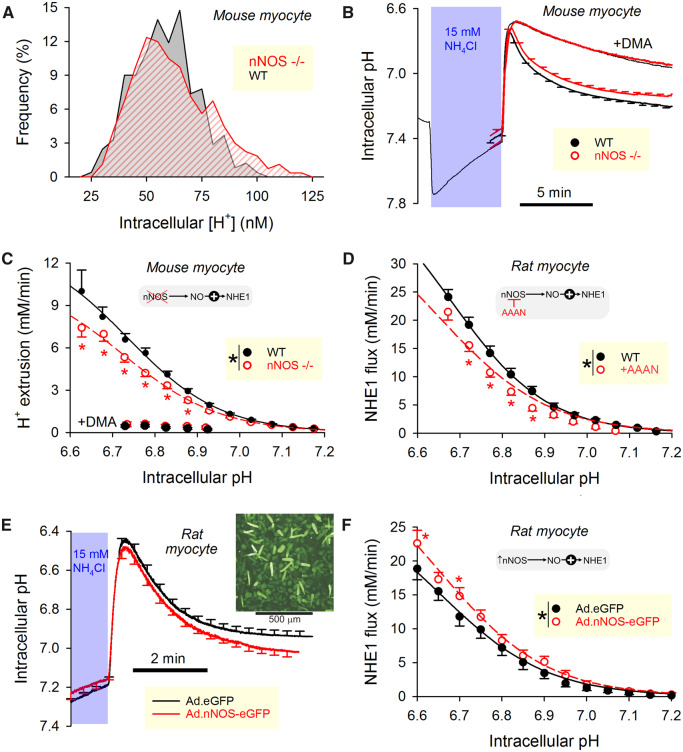
nNOS-derived NO activates NHE1 activity. (A) Histogram of resting [H+]i in ventricular myocytes isolated from nNOS knockout mice (N = 267 from five mice) or their wild-type littermates (N = 244 from five mice). (B) Time course of ammonium prepulse (mean ± SEM; N = 64 from five nNOS knockout mice and N = 54 from five wild-type littermates). Hepes-buffered superfusates, 37°C. Solution manoeuvre acid-loaded myocytes to interrogate acid-extrusion fluxes during recovery phase (blocked by 30 µM dimethylamiloride, DMA). (C) Flux calculated from the rate of pHi change and buffering capacity (Supplementary material online, Figure S2). NHE1-dependent fluxes were slower in nNOS knockout mice (P < 0.0001, two-way ANOVA). (D) NHE1 flux measured in wild-type rat ventricular myocytes. Hepes-buffered superfusates, 37°C. Treatment with selective nNOS inhibitor AAAN (5 µM; N = 16 from five rats) reduced activity relative to control (N = 18 from five rats) (P < 0.0001, two-way ANOVA). (E) Ammonium prepulse performed on adenovirally infected rat ventricular myocytes cultured overnight. Hepes-buffered superfusates, 37°C. Infected cells were identified by eGFP fluorescence (inset). (F) NHE1 activity was accelerated (P < 0.0001, two-way ANOVA) in myocytes infected with nNOS gene (N = 16 cells from four independent infections) compared to sham infected cells (N = 28 from five independent infection).